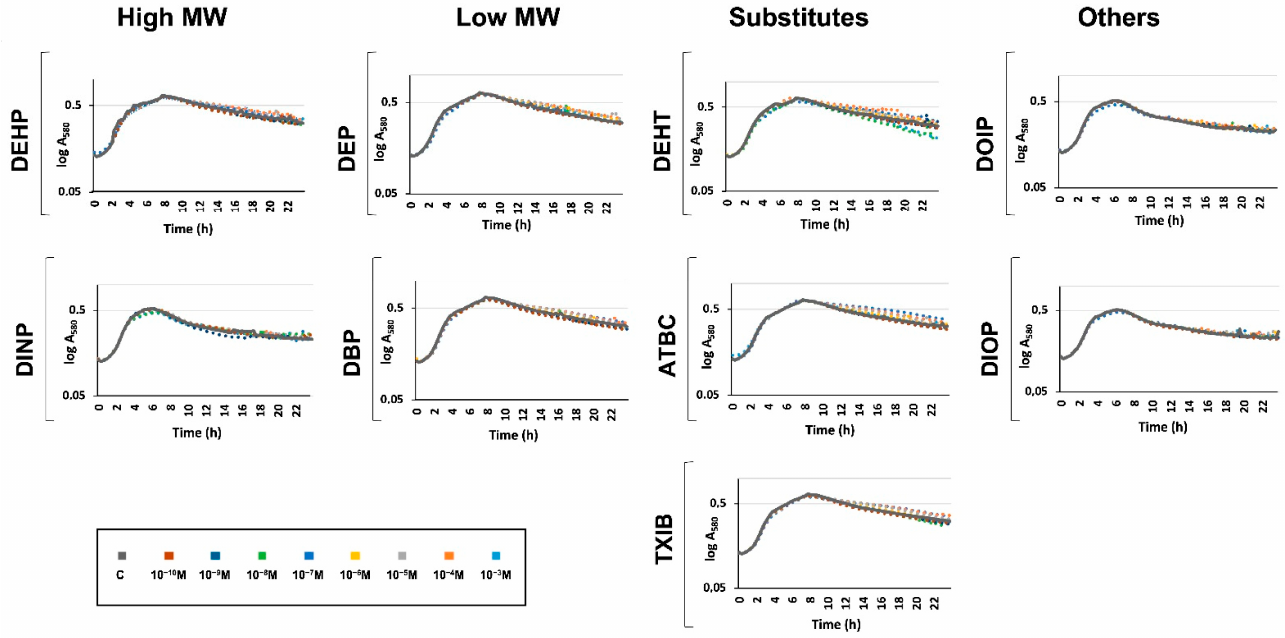
Figure 2. Phthalates or substitutes did not affect P. aeruginosa growth . Compounds were added at concentrations ranging from 10 − 10 to 10 − 3 M to the growth medium prior to P. aeruginosa inoculation. Growth was monitored for 24 h. GC: growth control in M9 containing succinate as sole carbon source without any phthalates or substitutes.